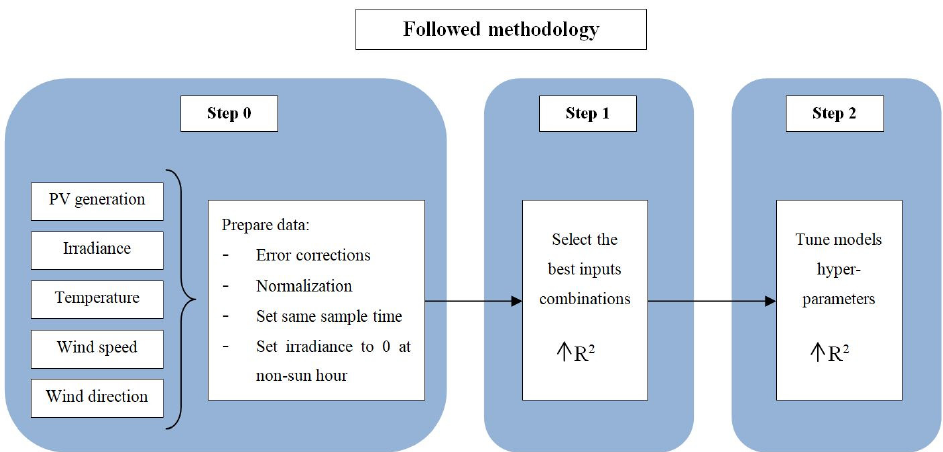
Figure 10. Methodology for developing AI-based models.